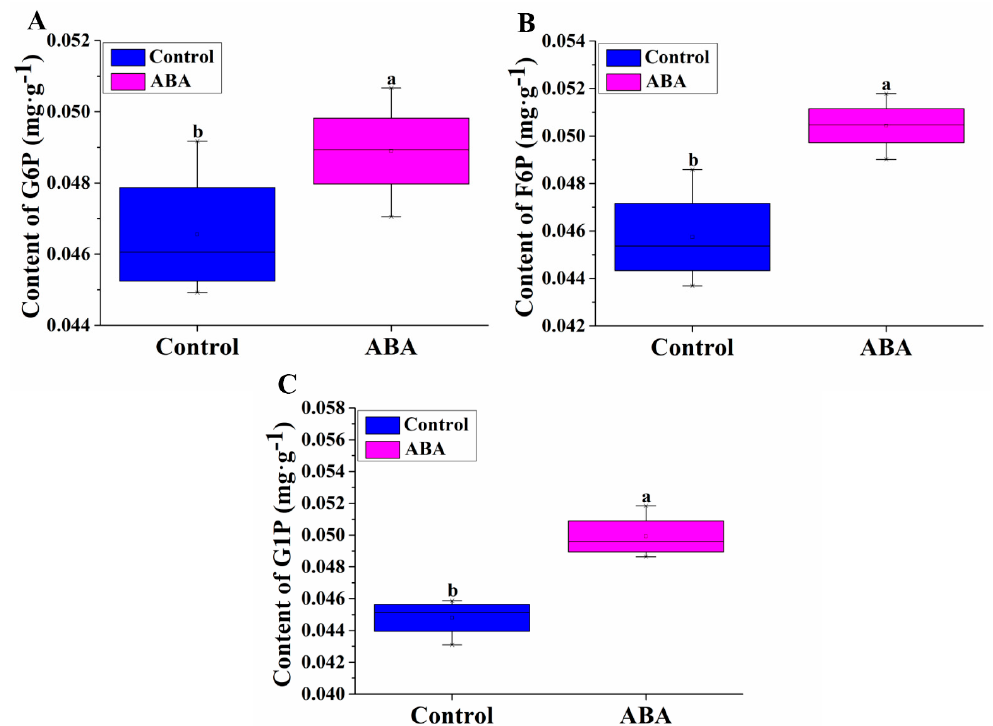
Figure 2. Effects of exogenous 0.05 µ M ABA on G6P ( A ), F6P ( B ) and G1P ( C ) contents in hypocotyls of cucumber. The values (means ± SE) are the average concentrations of the three independent experiments. The different letters above the bars indicate significant differences ( p < 0.05) according to one-way ANOVA and t test. G6P, glucose-6-phosphate; F6P, fructose-6-phosphate; G1P, glucose-1- phosphate.